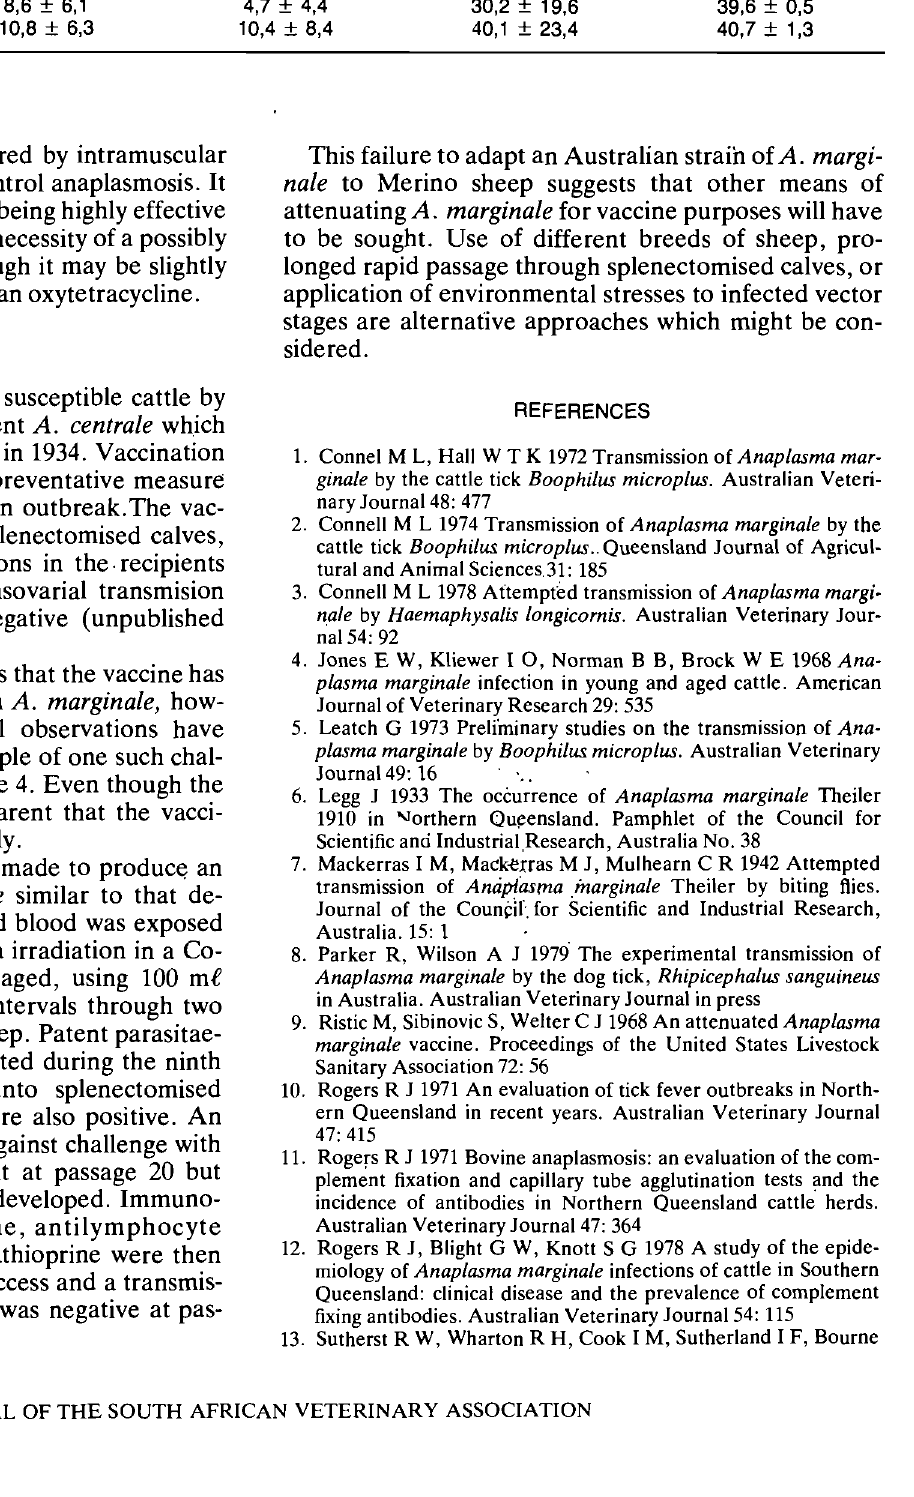
Table 4: RESPONSE OF ANIMALS PREVIOUSLY VACCINATED WITH BABESIA BOVIS, BABESIA BIGEMINA AND ANAPLASMA CENTRALE TO CHALLENGE WITH ANAPLASMA